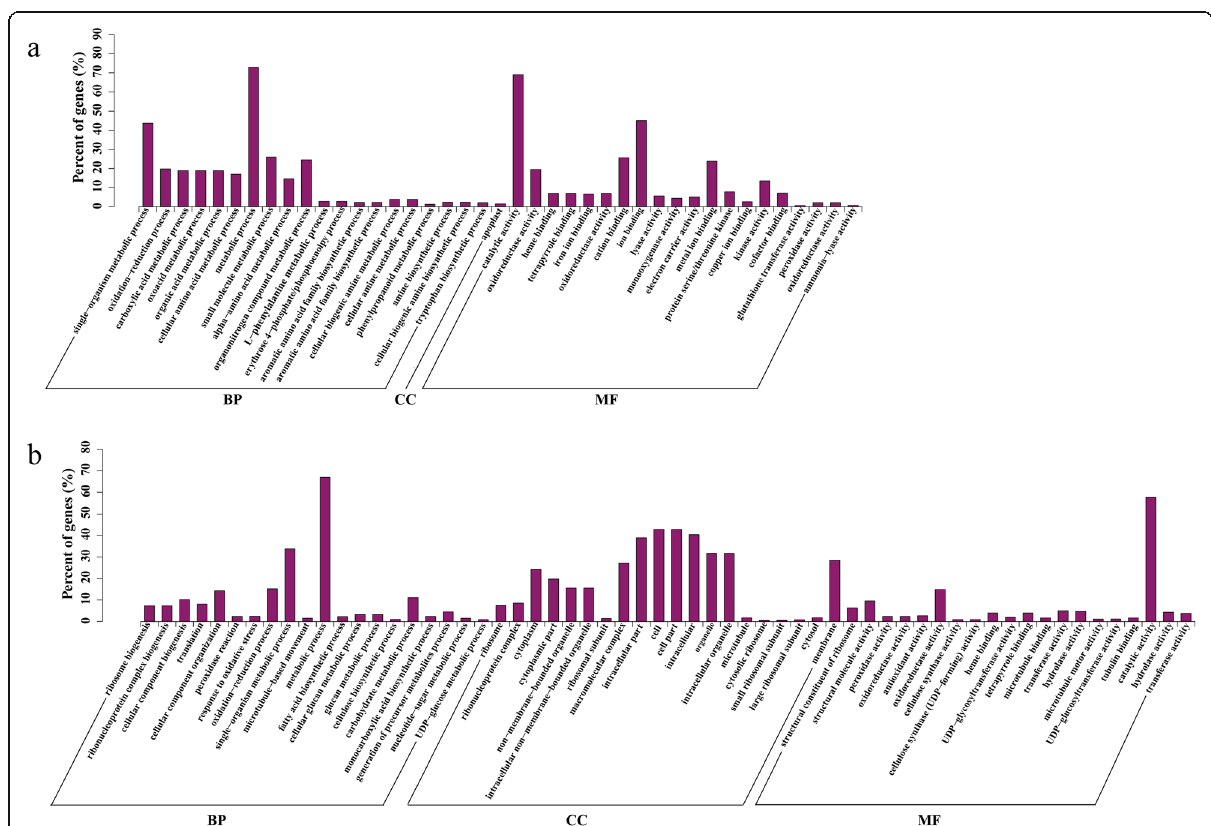
Fig. 5 GO analysis of differentially expressed wheat roots genes in response to infection by Ggt . a GO annotation of up-regulated DEGs ( Ggt- inoculated vs control). b GO annotation of down-regulated DEGs ( Ggt -inoculated vs control). GO annotation was divided into biological process (BP), cellular component (CC) and molecular function